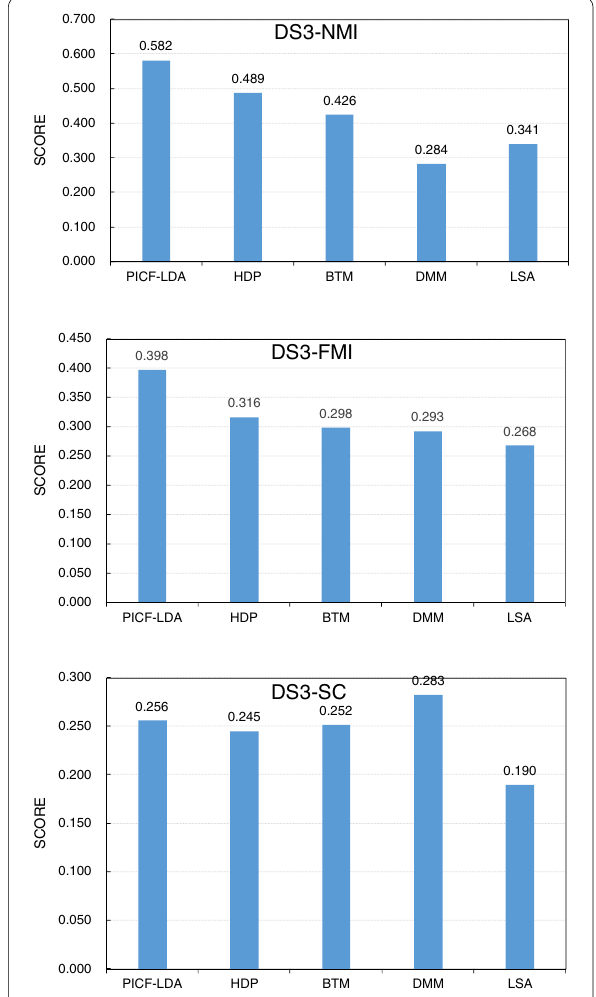
Fig. 11 Performance comparison between PICF-LDA and non-LDA models in DS3